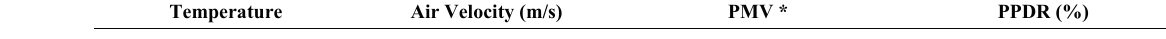
Table 3. Thermal comfort variables, showing values at four bed locations at centre of bed (height = 1.0